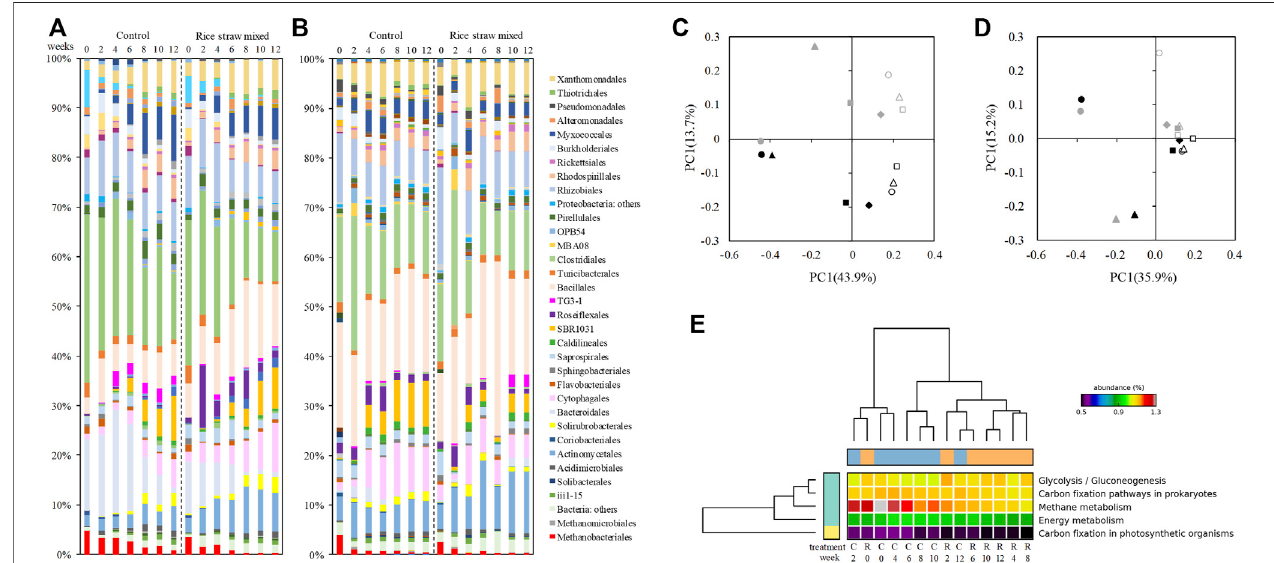
FIGURE 2 | Changes in the bacterial/archaeal community at the order level (A , B) and the results of the principal component analysis (PCA) (C , D) . (C) Run 1. (D) Run 2. Black symbols: Control manure heap. Gray symbols: Rice straw-amended heap. Filled circles: week 0. Filled triangles: week 2. Filled squares: week 4. Filled diamonds: week 6. Open circles: week 8. Open triangles: week 10. Open squares: week 12. (E) Estimated microbiome functions in Run